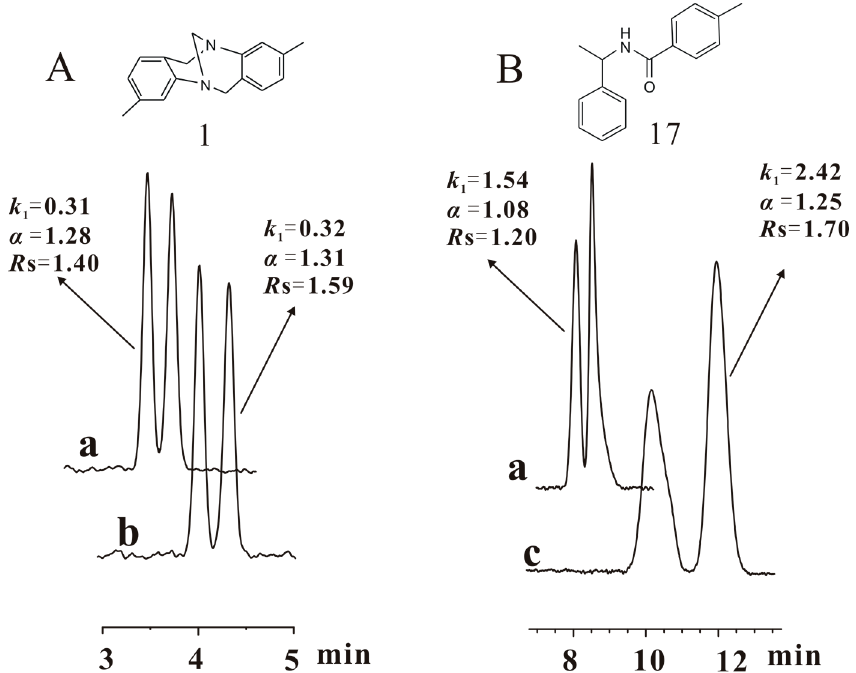
Figure 6. Chromatograms of compounds 1 (Tröger´s base) ( A ) and 17 ( B ) baseline separated again by CSP 5 under condition V with changed mobile phases. a: obtained in the mobile phase ( n -hexane/ethanol (90/10)) for general enantioseparation evaluation under condition V; b: obtained in the specifically changed mobile phase ( n -hexane/ethanol (93/7)) for baseline separation of compound 1 under condition V; c: obtained in the specifically changed mobile phase ( n -hexane/ethanol/isopropanol (90/5/5)) for baseline separation of compound 17 under condition V. Column size: Φ 250 mm × 4.6 mm; flow rate: 1 mL/min; detection temperature: 25 °C, UV wavelength: 242 nm.